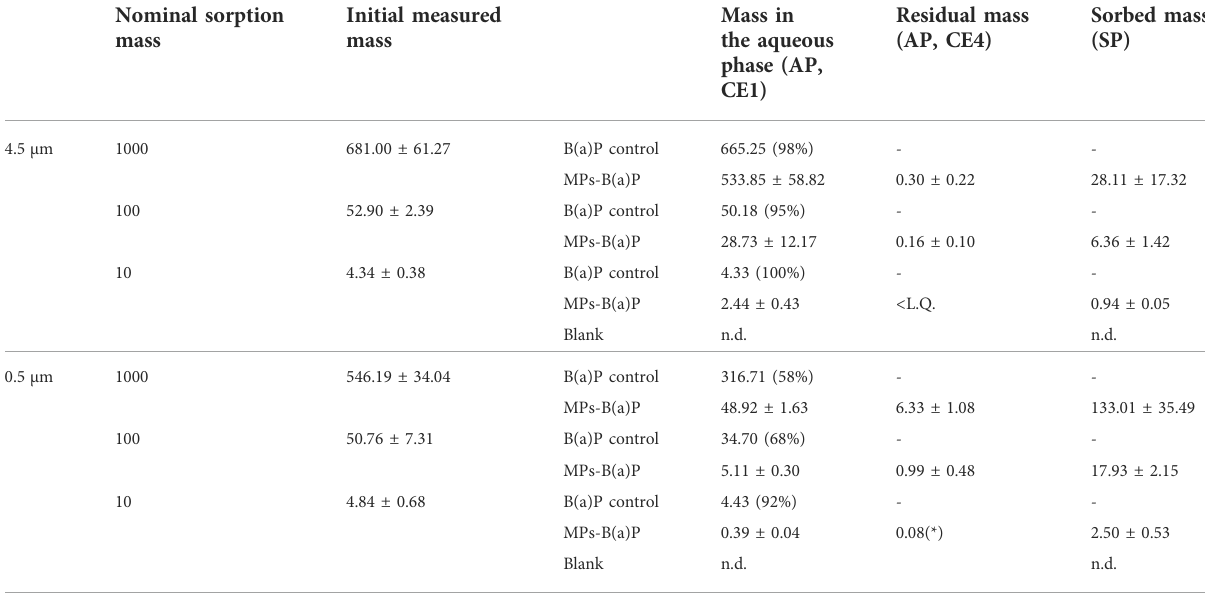
TABLE 2 B(a)P mass (in ng) in the different measured